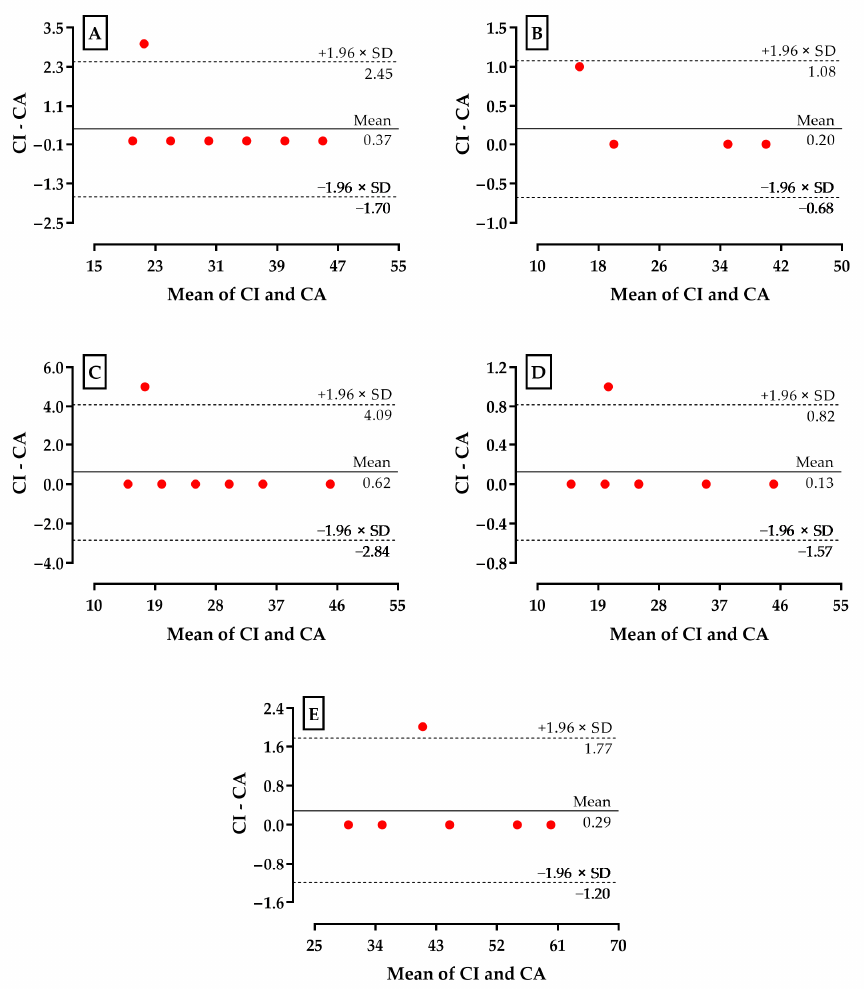
Figure 4. Bland–Altman plots showing the mean difference ( y -axis) and 95% agreement limits ( ± 1.96 × SD, dotted lines) between the two HMM methods (with environmental measurements (CA) and using only image coordinates without environmental measurements (CI) for the analysis of the number of states ( N ) required to recognize differences in positional sequence of elbow, shoulder and barbell during biceps-curl. Panels A and B depicted comparisons for shoulder (with load at 50% and 25%), Panels C and D for elbow (with load at 50% and 25%), and Panel E for barbell (with load at 50%).